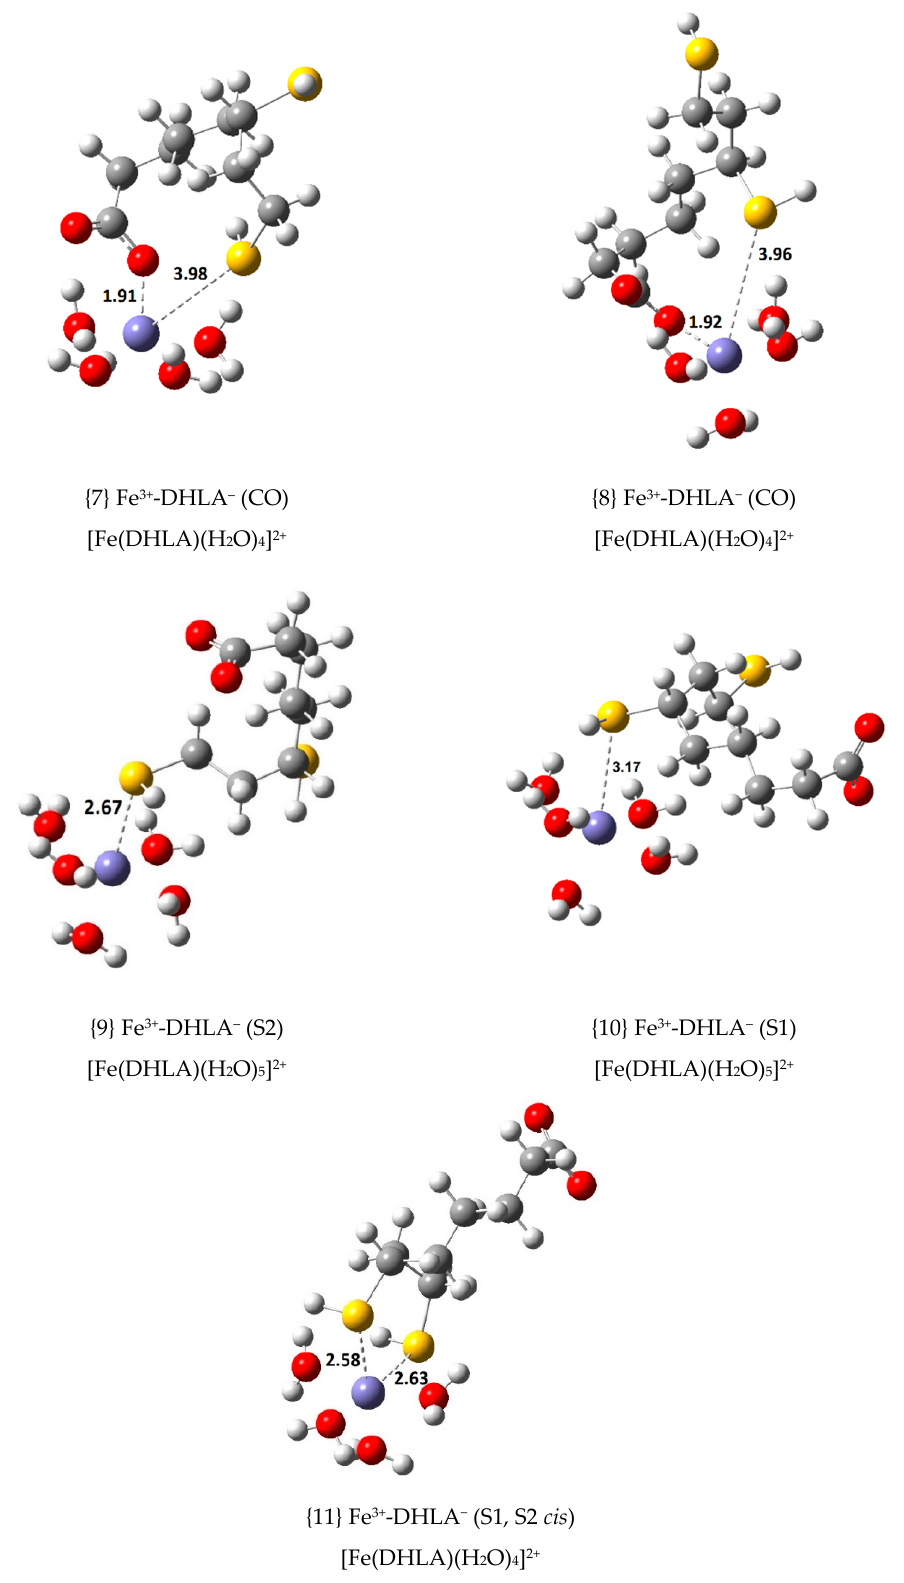
Figure 3. Optimized geometries of the 1:1 complexes of Fe(III) with dihydrolipoic acid, DHLA − (bond distances in Å).